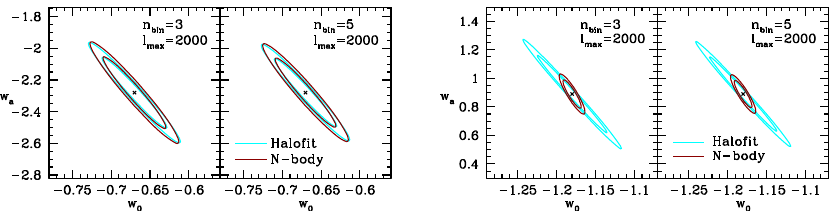
Fig. 28 On the left (right) panel, 1- and 2- σ contours for the M1 (M3) model. The two fiducial models exhibit quite different